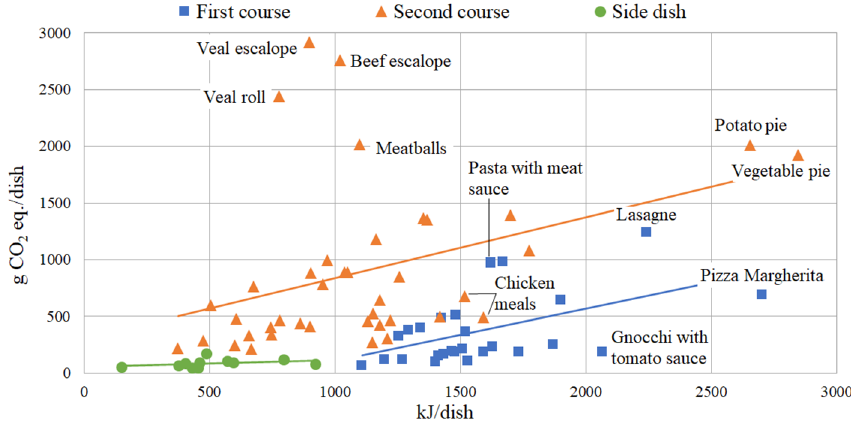
Figure 4. Carbon footprint (CF) of the analysed meals: first courses, second courses and side dishes.